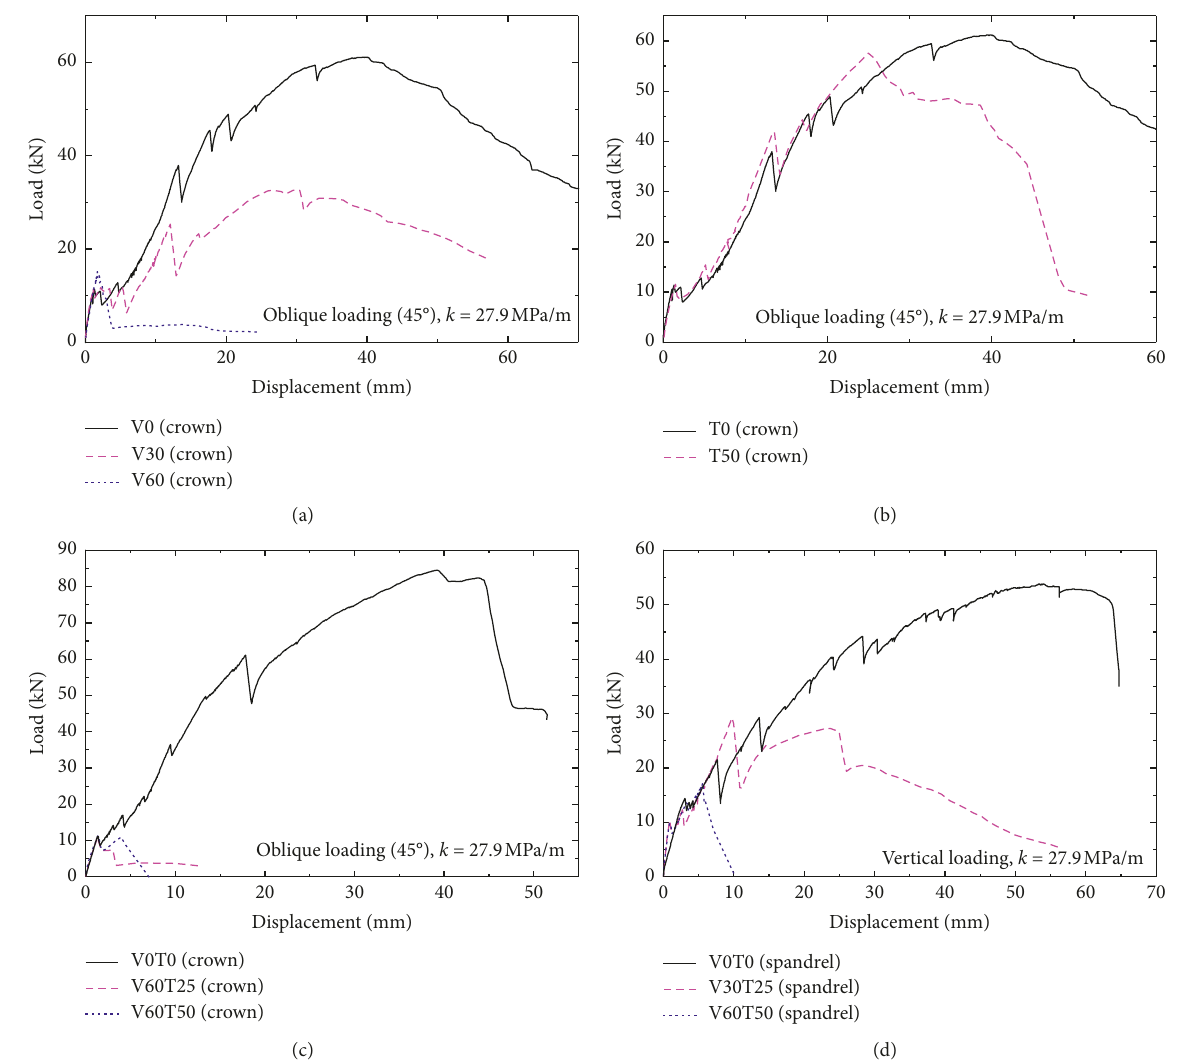
Figure 4: Load-displacement curve of lining defects. (a) Vault crown voids of the lining. (b) Insufficient vault crown thickness of the lining. (c) Combined vault crown defects of the lining. (d) Combined spandrel defects of the